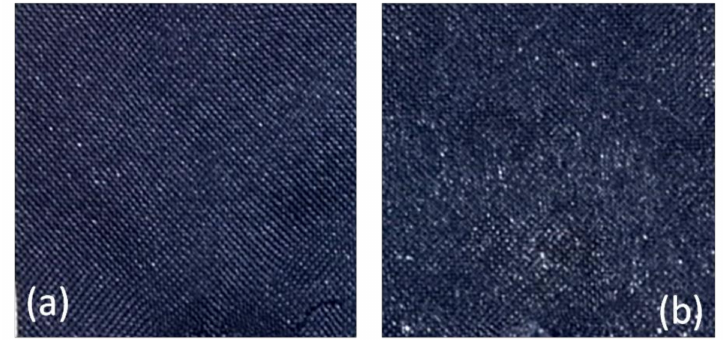
Figure 5. Appearance of the initial fabric ( a ) and after PUD treatment ( b